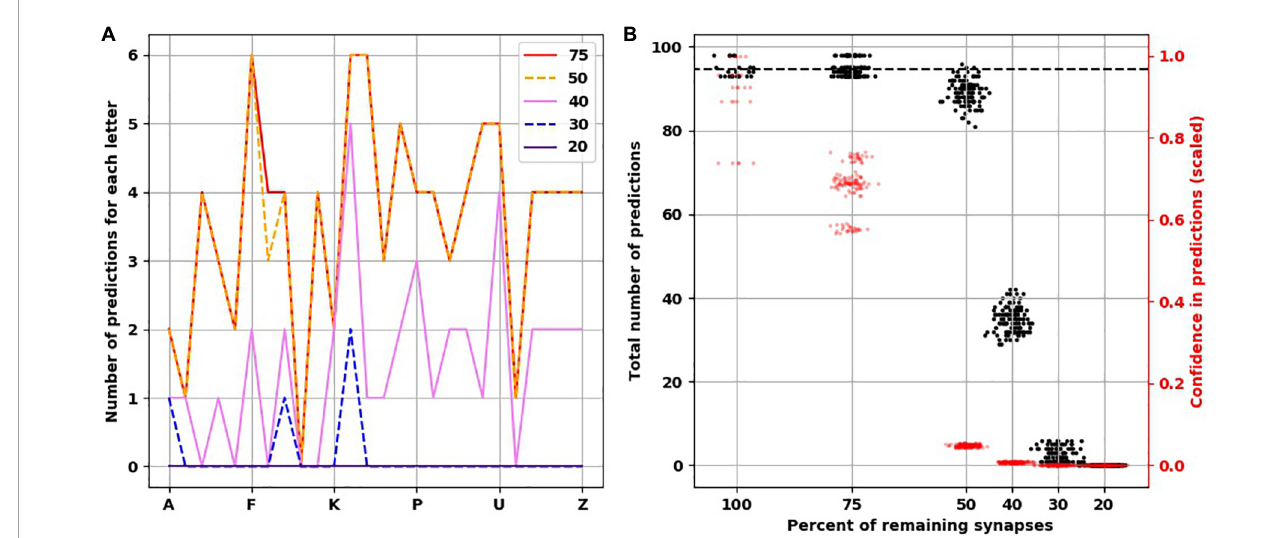
FIGURE4 Reduced confidence in predictions before number of predictions is decreased with destroying synapses. (A) Illustrative example from the same network in Figure 3 showing the progressive reduction in number of predictions for each letter with loss of synapses. Each colored line represents the number of remaining synapses. Of note, the number of predictions from network with remaining 75% is identical to network with 100% of synapses. (B) At 75% of synapses, the networks encoded similar number of predictions as 100% of synapses, but with less confidence. At 50% of synapses, there is a slight reduction of number of predictions, but the confidence is less than 0.1. There is marked reduction of number of predictions at 40 and 30% of synapses. No predictions could be generated with 20% of synapses. There are 25 simulations at 100%, and 125 simulations at the remaining percentages.